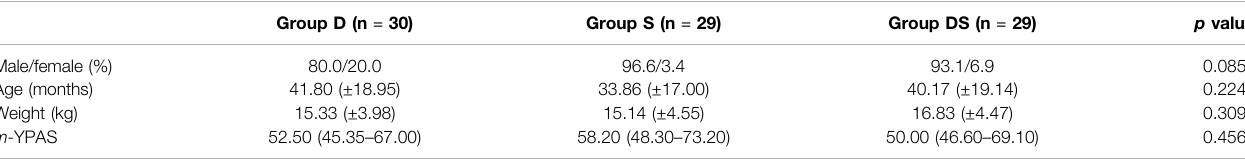
TABLE 2 | Demographic data and preoperative anxiety score.